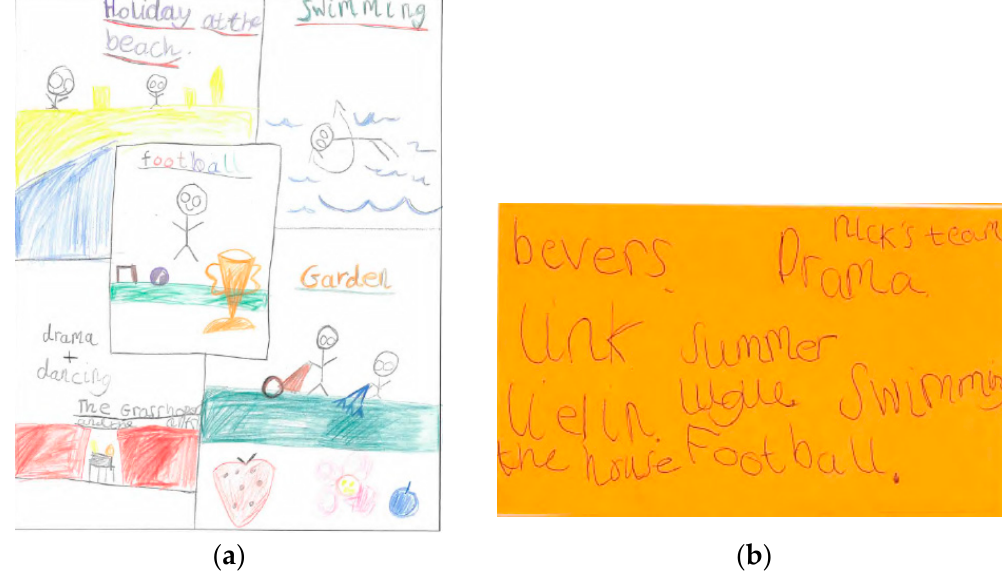
Figure 4. ( a , b ) Write, draw, show and tell (WDST) data for Matthew Jones, illustrating leisure activities. “Well, holiday. When I went to Malaga in Spain. When I went to Mummy ʹ s cousin ʹ s. Making sandcastles and jumping on the waves. I enjoy swimming. And this is me in the garden. Daddy ʹ s doing the wall, and I ʹ m doing where you cut the grass at the side. And this one here is me playing football for my team. And drama and dance. We ʹ ve just done a show. I was Adam Ant” [Matthew Jones].